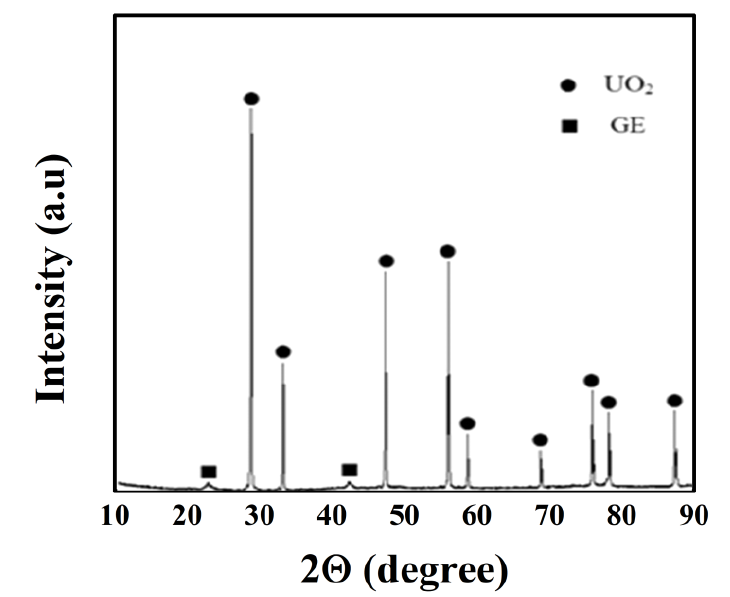
Figure 4. XRD images of UO 2 –graphene sintered pellets.